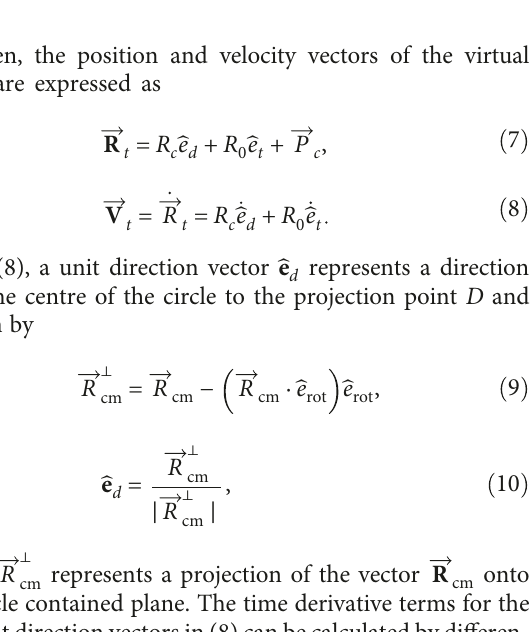
Figure 4: Path segment switching.